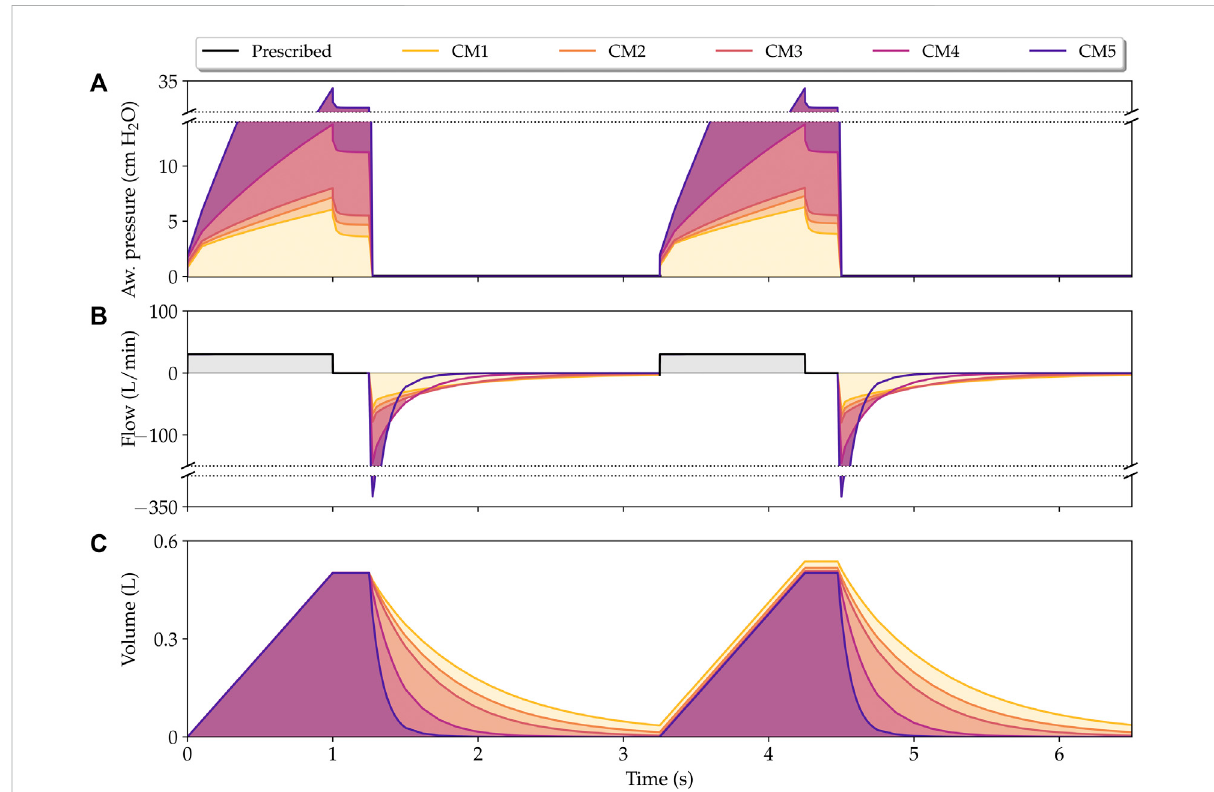
FIGURE 7 Simulation of lungs under volume-controlled mechanical ventilation. Physiological signals that describe the time evolution of airway pressure (A) , fl ow (B) , and volume (C) are shown for all constitutive models considered in this work. The y -axis was broken for the clarity of the plot.